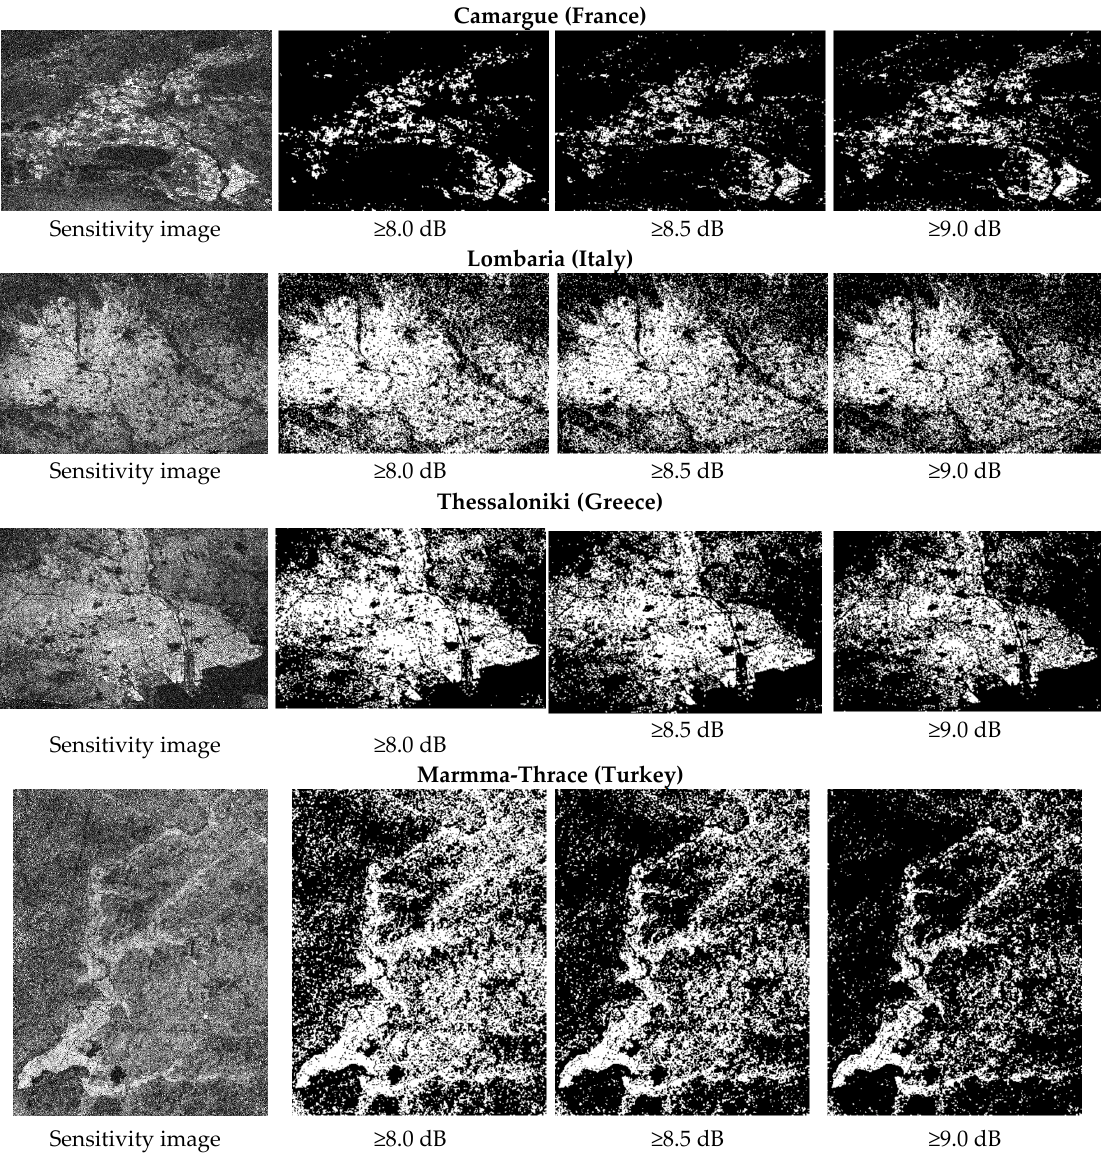
Figure 7. Sensitivity images and potential rice cropland area extent results using different thresholds.